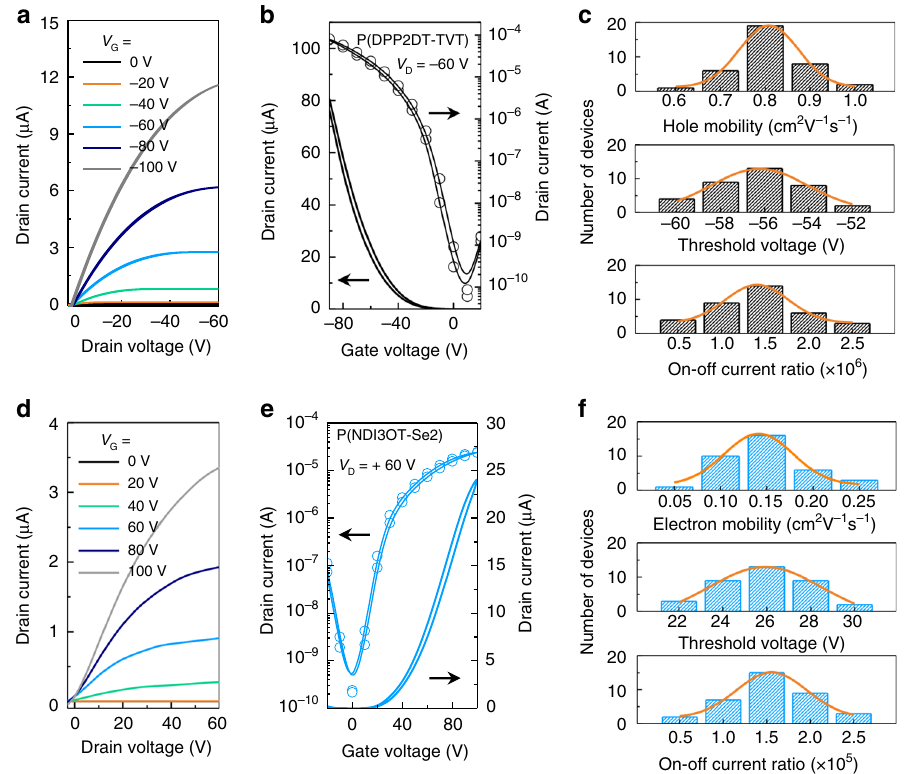
Fig. 4 Electrical characteristics of all-photopatterned PTFTs. a Output and b transfer characteristics of PTFTs based on P(DPP2DT-TVT) crosslinked using 1 wt% of 4Bx. c Summary of hole mobility (top), threshold voltage (middle), and on – off current ratio (bottom) of 36 P(DPP2DT-TVT) PTFTs. d Output and e transfer characteristics of PTFTs based on P(NDI3OT-Se2) crosslinked using 1 wt% of 4Bx. f Summary of electron mobility (top), threshold voltage (middle), and on – off current ratio (bottom) of 36 P(NDI3OT-Se2) PTFTs. Table 1 Summary of electrical characteristics of 36 all-solution-processed, all-photopatterned PTFTs. Semiconducting polymer